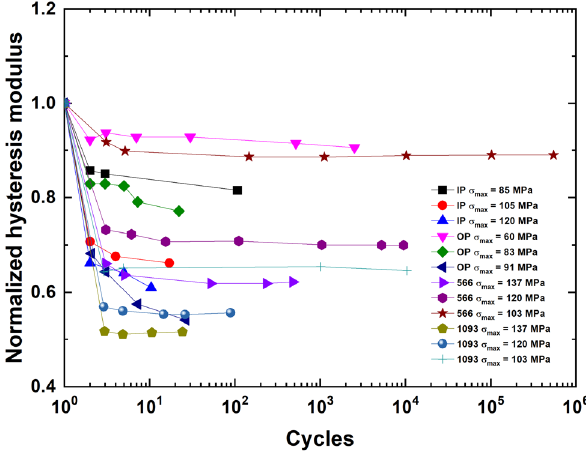
Figure 13: Evolution of FHM versus applied cycle of cross - ply SiC/ MAS composite under IP - and OP - TMF and IF loading.